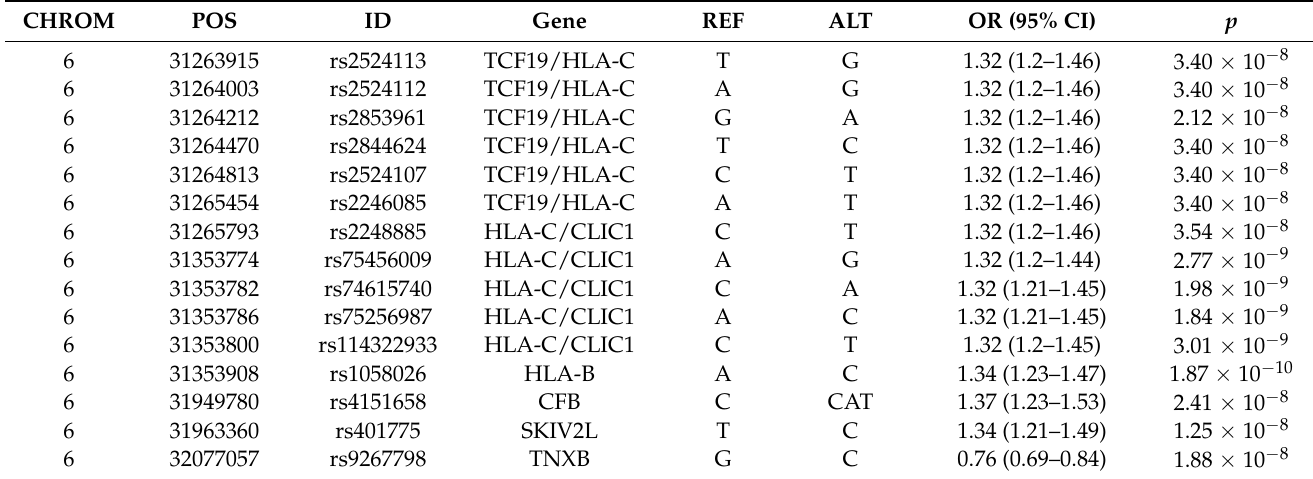
Figure 1. ( A ) Quantile–quantile plot of observed p -values for associations. The data indicate only a small amount of population inflation ( λ = 1.023). ( B ) Manhattan plot of genome-wide p -values for associations. Red line indicates p = 5 × 10 − 8 . Only SNPs in 6p21 reach genome-wide significance. Table 2. Significant variants ( p < 5 × 10 − 8 ) associated with oral cancer in the Taiwanese.